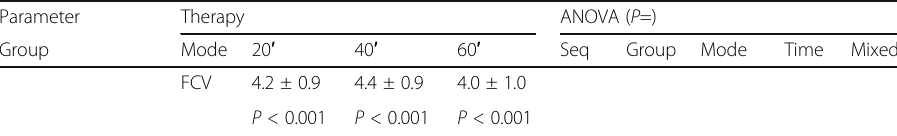
Table 2 Respiratory parameters (Continued)